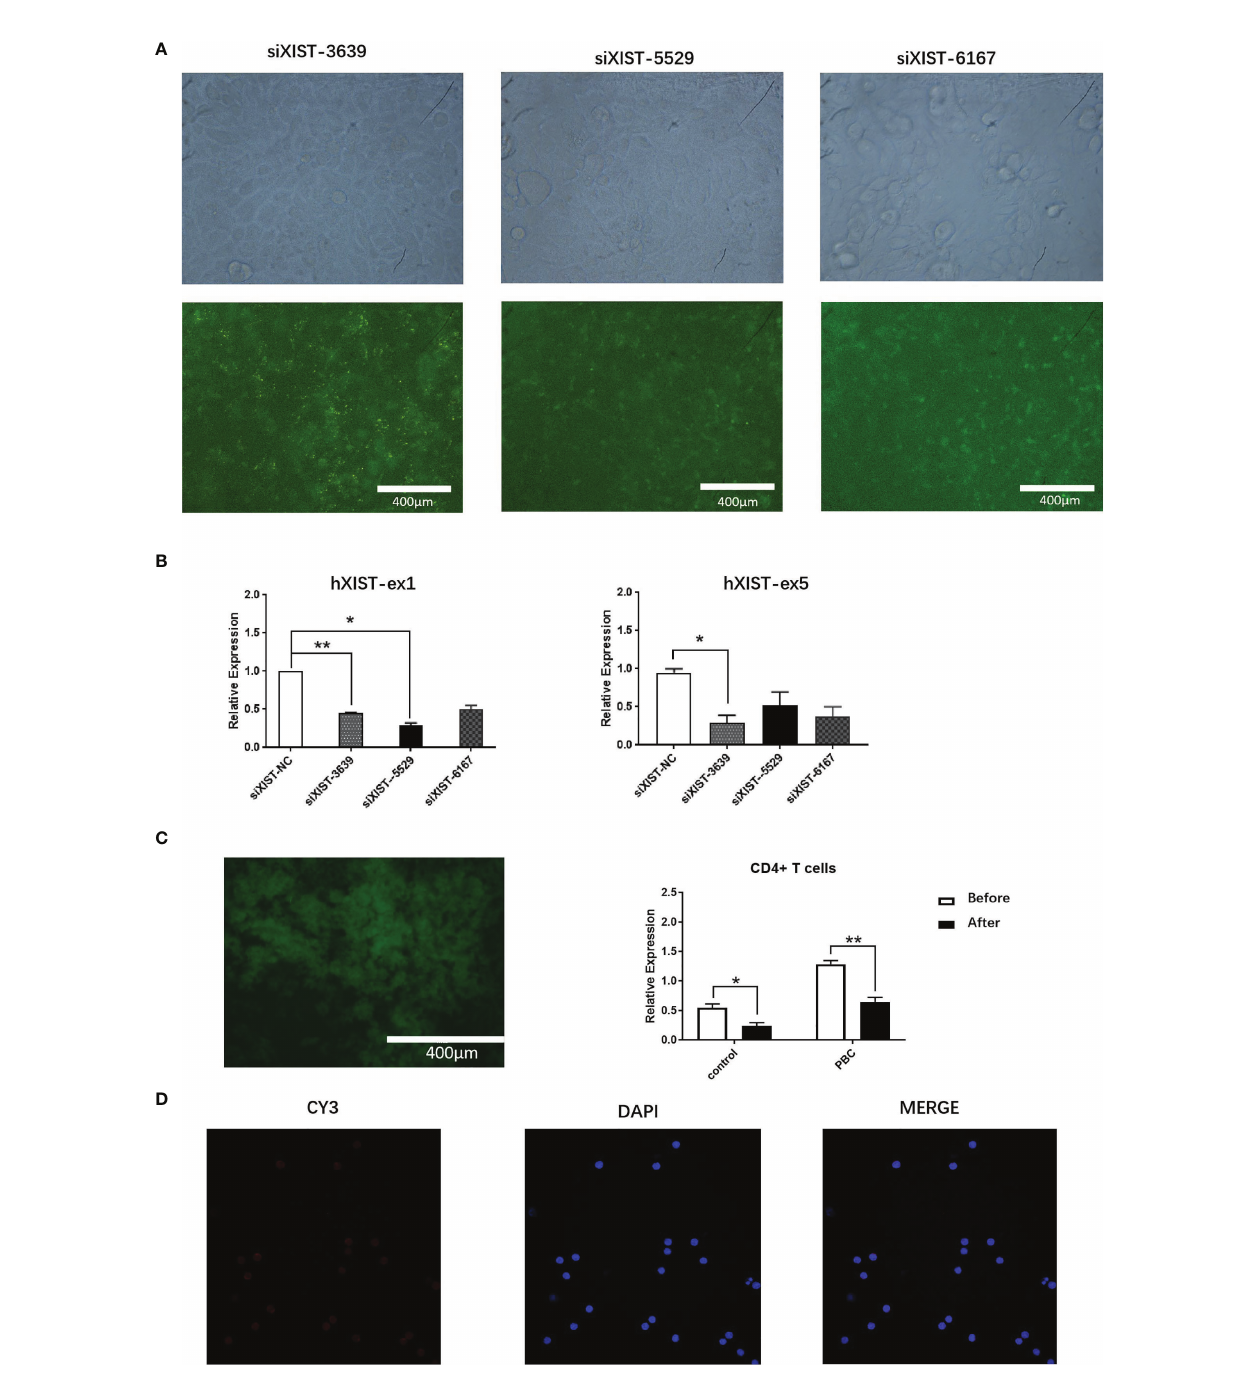
FIGURE 3 | Expression interference of LncRNA XIST in CD4+ T cells of PBC patients. (A) Representative images ( fl uorescent microscope) and naive CD4+ T cells were transfected with siXIST-3639, siXIST-5529, or siXIST-6167, respectively. (B) The levels of XIST-ex1 and XIST ex-5 were examined by qRT-PCR in naive CD4+ T cells transfected with siRNA negative control (siXIST-NC), siXIST-3639, siXIST-5529, or siXIST-6167, respectively. The data are presented as mean±SEM of three independent experiments (n=3 *p < 0.05; **p < 0.01). (C) Representative images ( fl uorescent microscope) and qRT-PCR was used to detect the expression of LncRNA XIST at RNA level after naive CD4+ T cells were transfected with lentiviral oeXIST. The data are presented as mean±SEM of three independent experiments (n=3, *p < 0.05; **p < 0.01). (D) Representative images (confocal laser scanning microscope) and LncRNA XIST is localized in the nucleus of naive CD4+ T cells were transfected with lentiviral